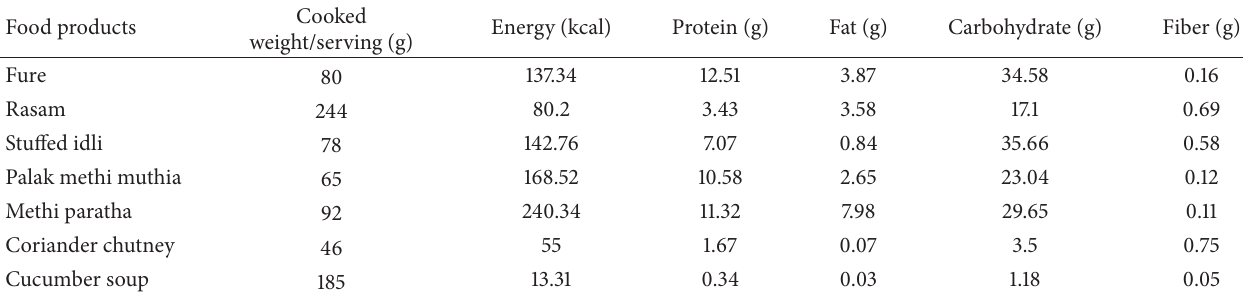
Table 3: Nutritive evaluation of food products developed by incorporation of 3 g Catharanthus roseus fresh leaves per serving. Food